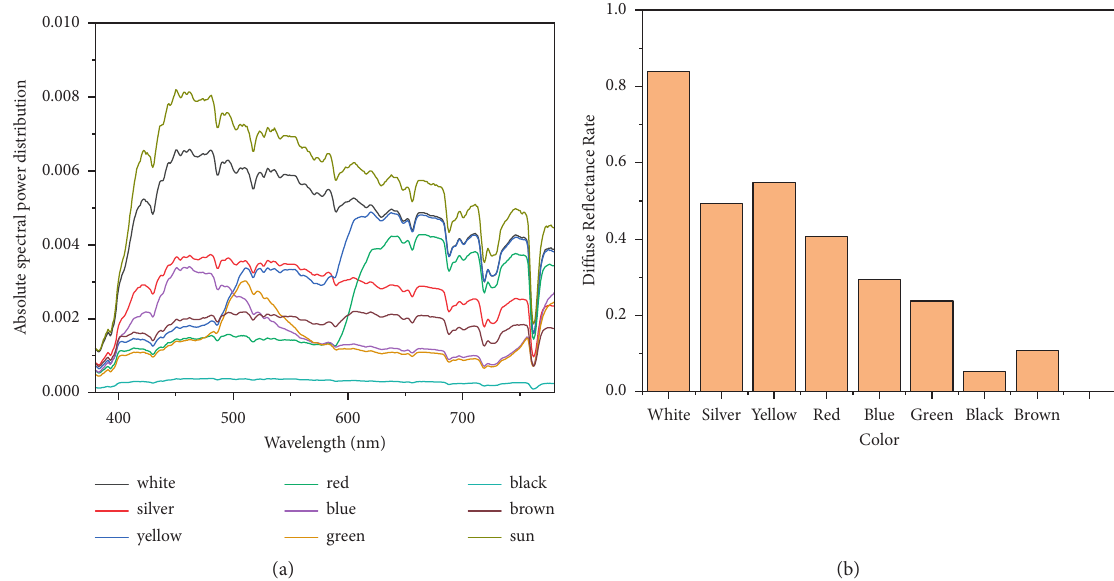
Figure 17: (a) The SPDs of eight targets with different colours of targets and backgrounds. (b) The diffuse reflectance of eight targets withdifferent colours.